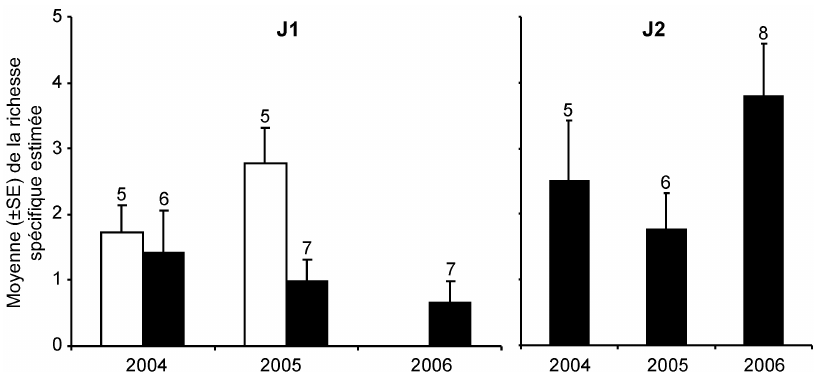
Fig. 2. – Variation de la moyenne de la richesse spécifique estimée chez les tamias juvéniles de la première (J1) et de la seconde (J2) cohorte (histogrammes blancs : mai-juillet; histogrammes noirs : août-novembre) en 2004, 2005 et 2006 en Forêt de Sénart. Le nombre de sessions bi-mensuelles est indiqué au-dessus des histogrammes.